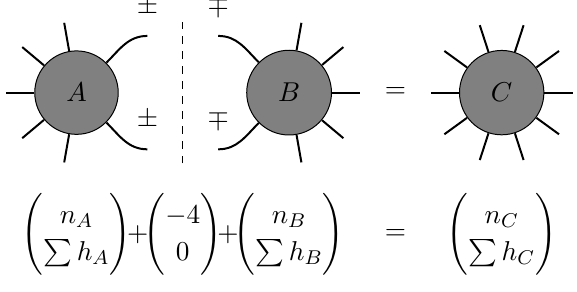
Figure 5 . The one-loop level rule for constructing amplitudes in ( n; P h ) space